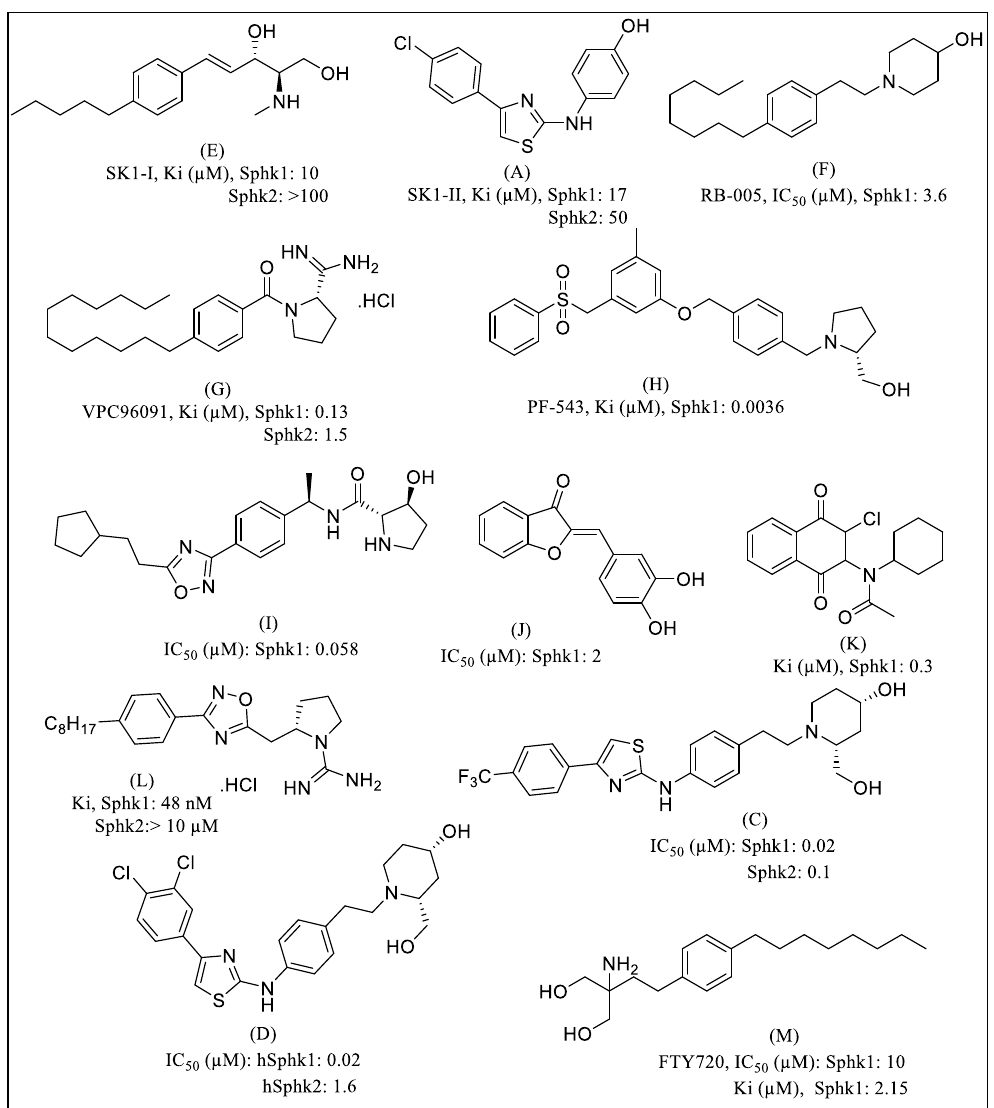
Figure 1. Chemical structure of thiazole-based sphingosine kinase 1 inhibitor.